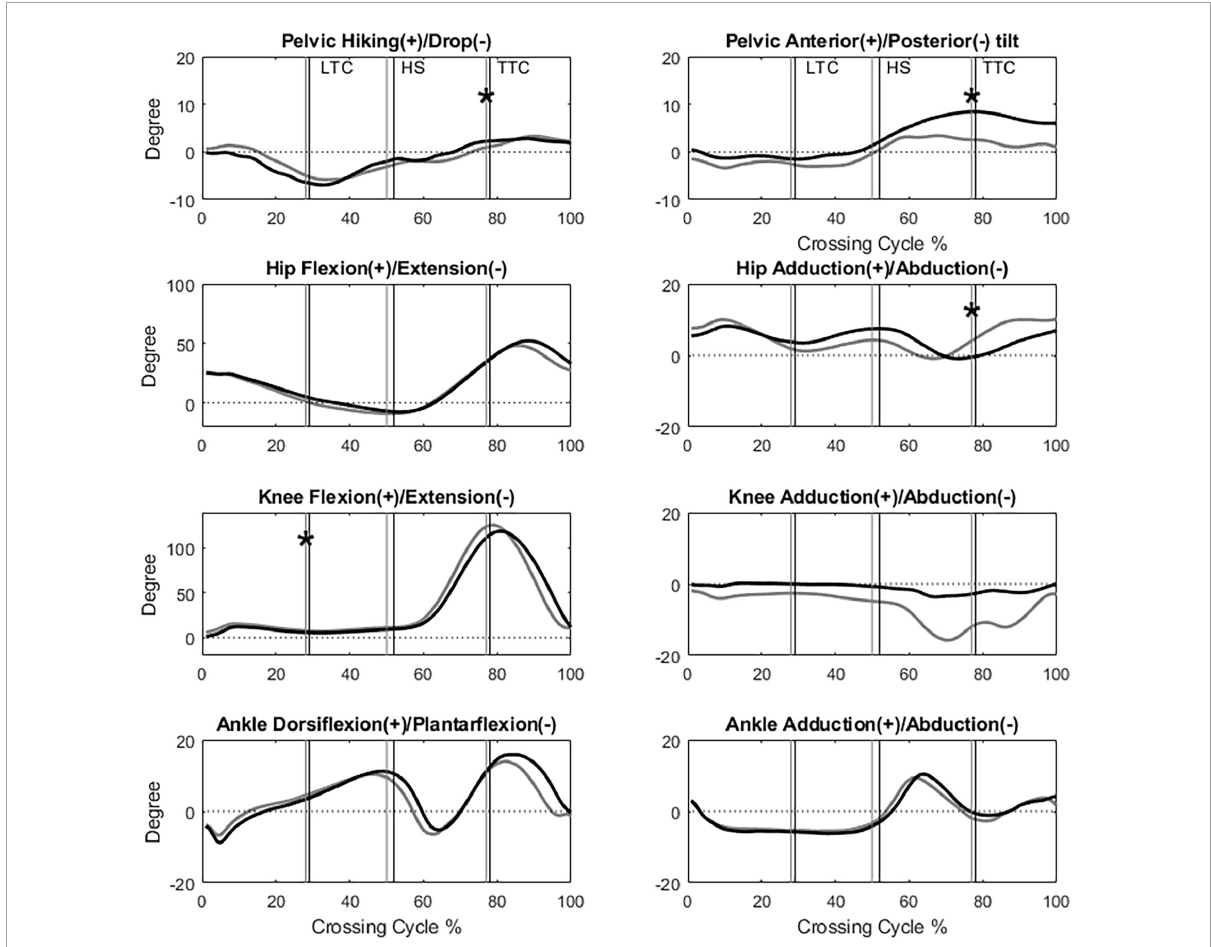
FIGURE3 The angles of the pelvis, hip, knee and ankle joints of the trailing limb in the sagittal and frontal plane of typical subjects of the TCC (black) and Control (gray) groups when crossing obstacles of 30% of leg length (LTC, leading toe above the obstacle; HS, heel-strike of the leading limb; TTC, trailing toe above the obstacle; *: Significant main group effect, p <